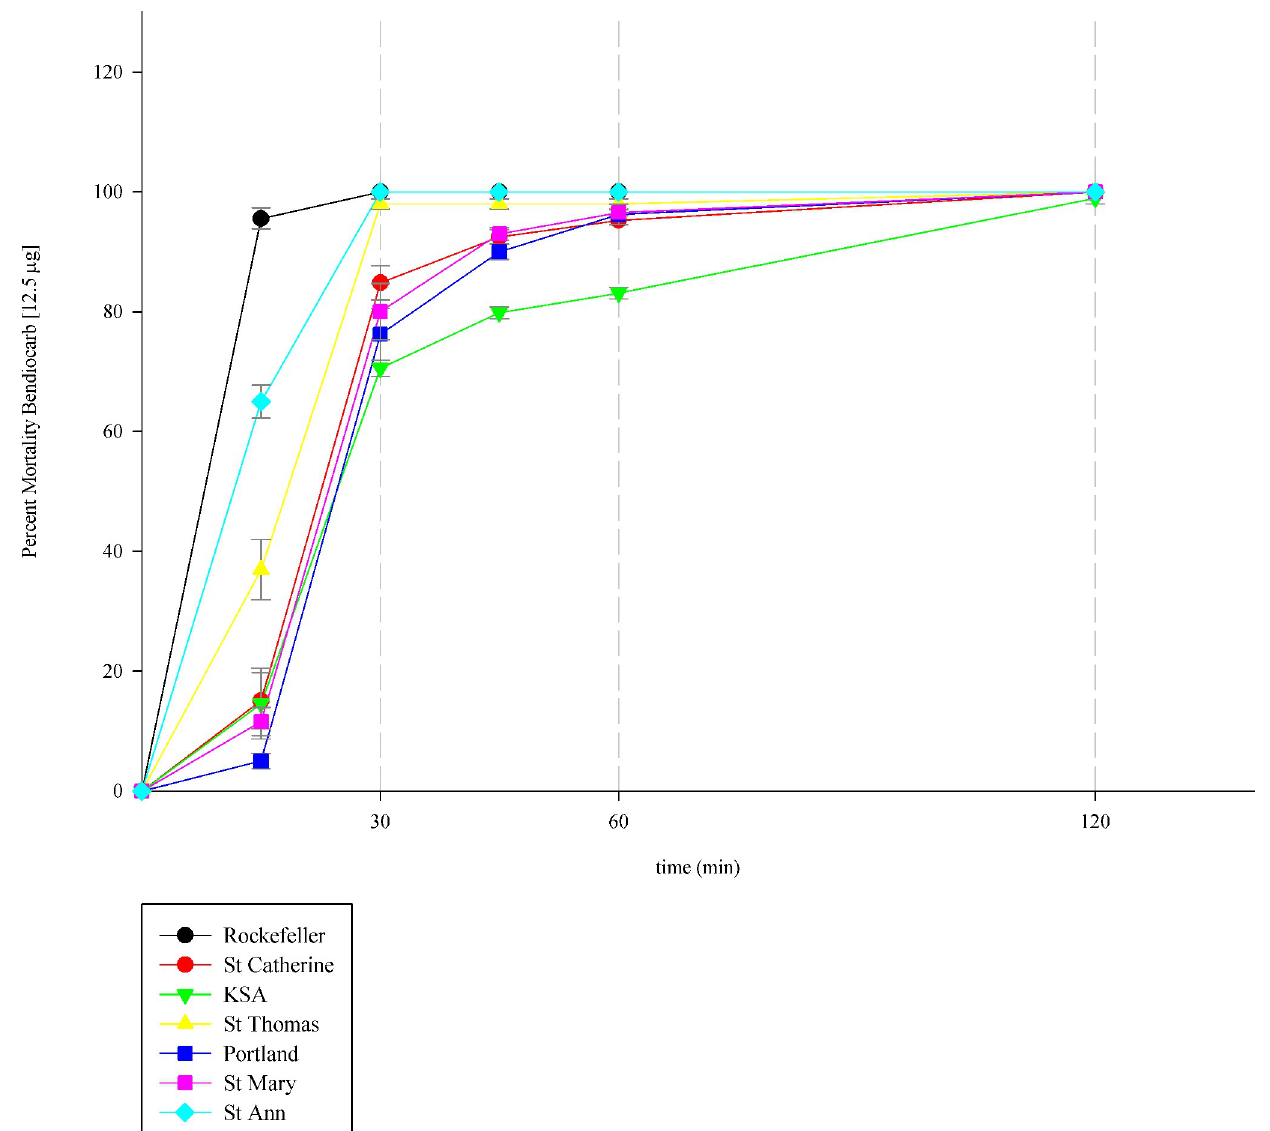
Fig 5. Bendiocarb susceptibility. The effect of bendiocarb on Ae . aegypti females from the eastern parishes of Jamaica using the CDC diagnostic dose of 12.5 μ g/bottle. Demarcation lines on the graph show the effect of bendiocarb at the CDC diagnostic time of 30 minutes, at 60 minutes, and at 120 minutes. The data are summarized as mean 95% CI.